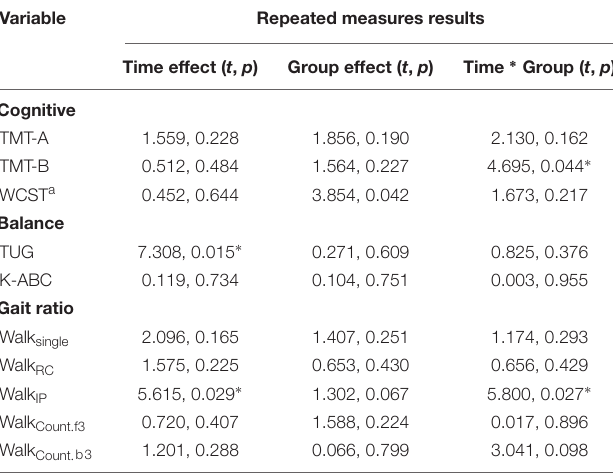
TABLE 4 | The results of a mixed model repeated measures ANOVA. Variable